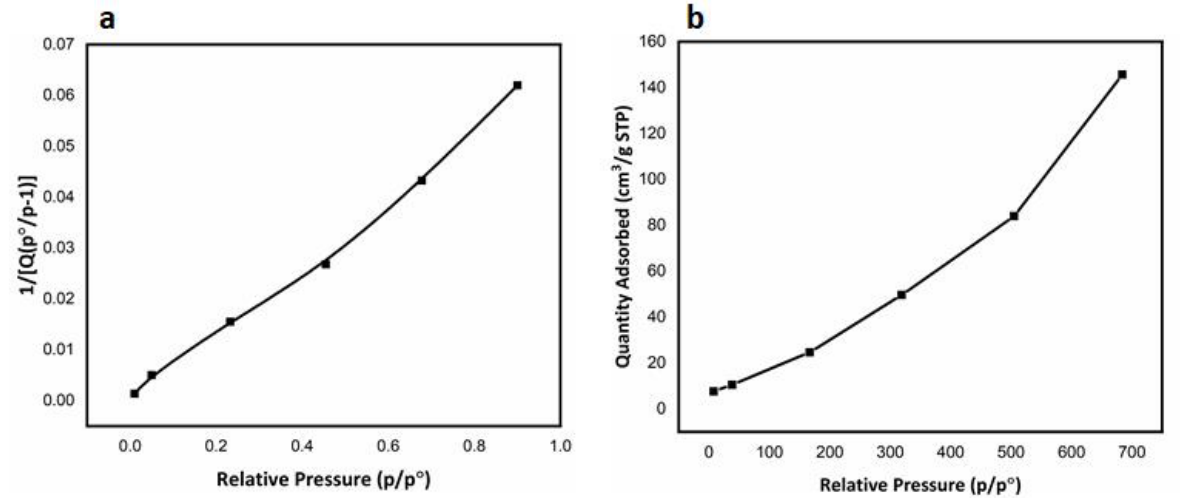
Figure 5. ( a ) BET surface area plot and ( b ) Langmuir surface area plot of Fe 3 O 4 NHS showing the intent of N 2 adsorption over the surface of Fe 3 O 4 NHS upon increasing relative pressure.